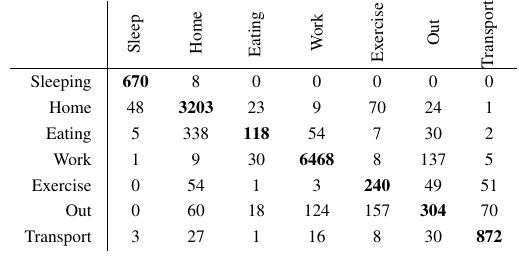
TABLE III: Confusion matrix of the final machine-learning approach on the seven daily activities